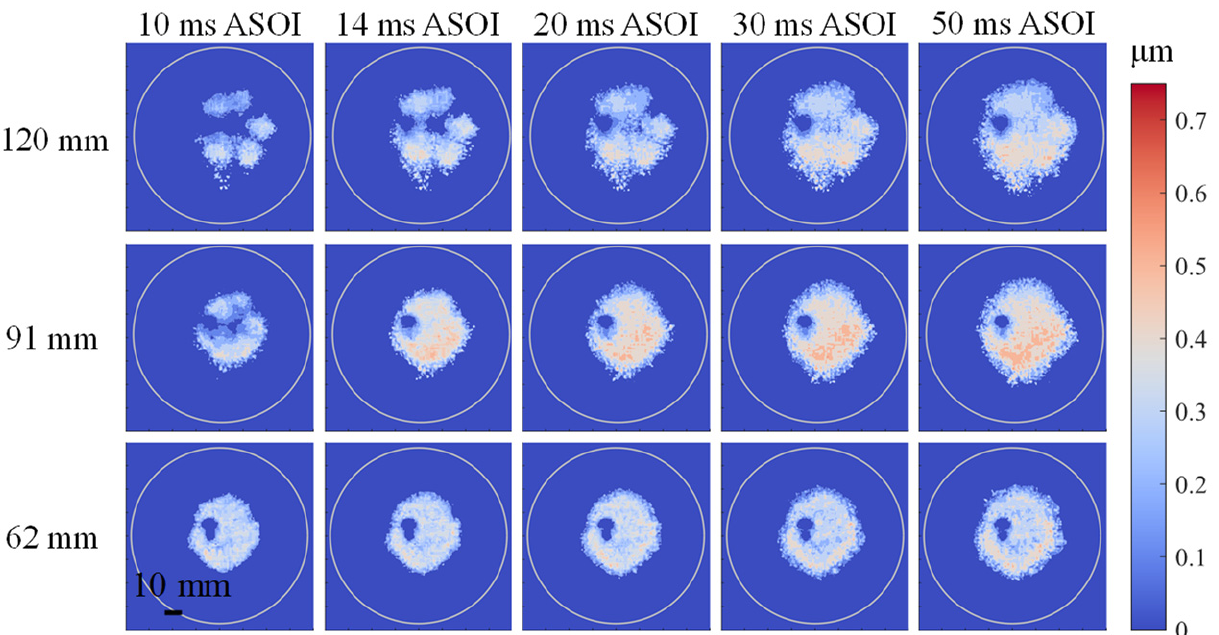
Figure 13. Pseudo color images of fuel film on the wall with temperature 293 K under different D imp . As described before, results only from 10 ms ASOI were available for analysis.